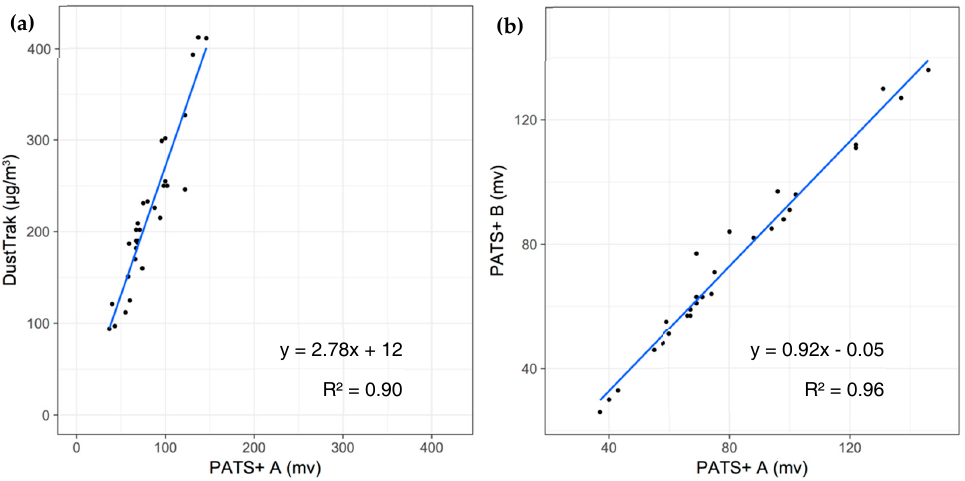
Figure 4. Correlation of ( a ) PATS+ and DustTrak and ( b ) PATS+ intra-instrument comparison during the Beijing monitoring period (see Figure 3). Each data point represents a one-hour average.